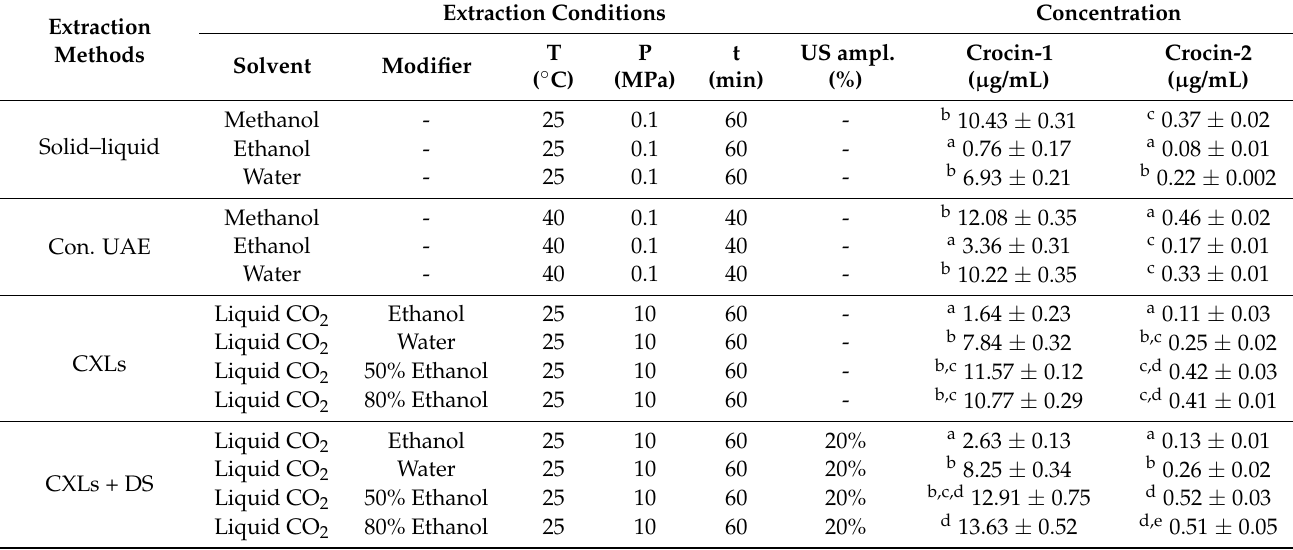
Table 3. Extraction conditions and concentrations using different